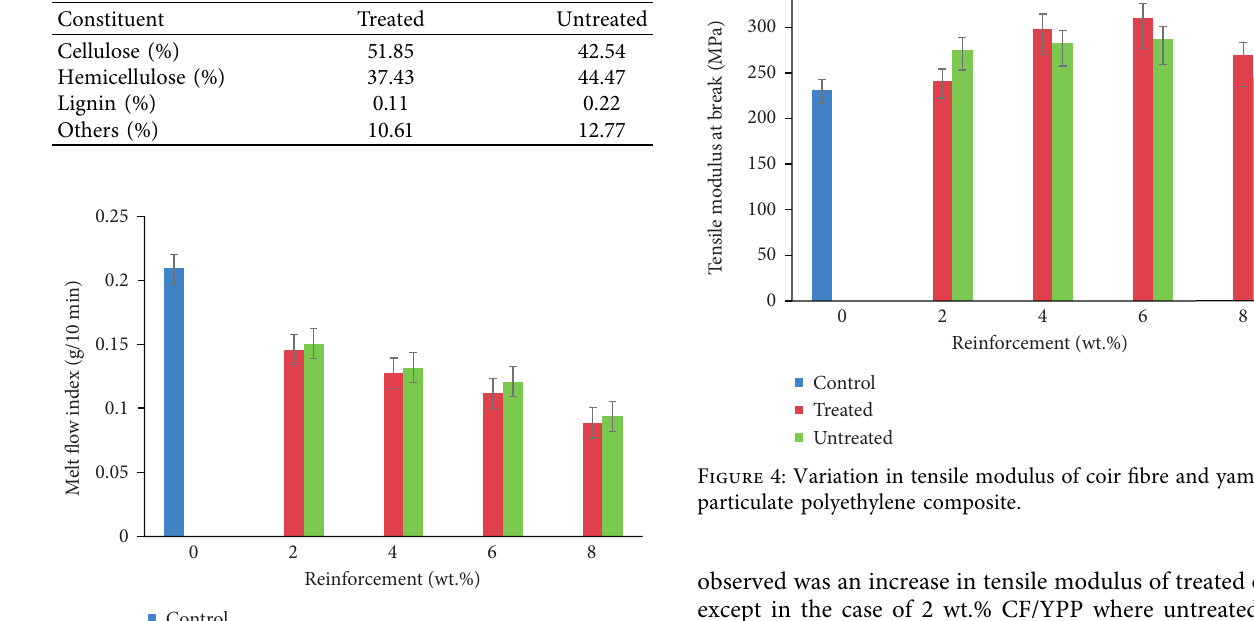
Table 2: Compositional analysis of coir fibre.